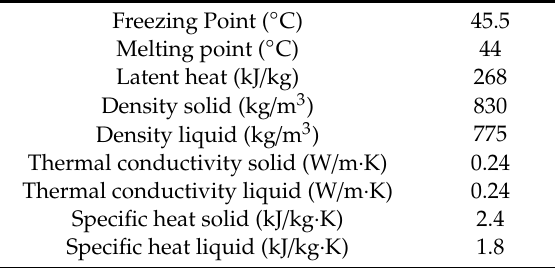
Table 1. Thermal and physical properties of organic A44 PCM used in the experiments [38].